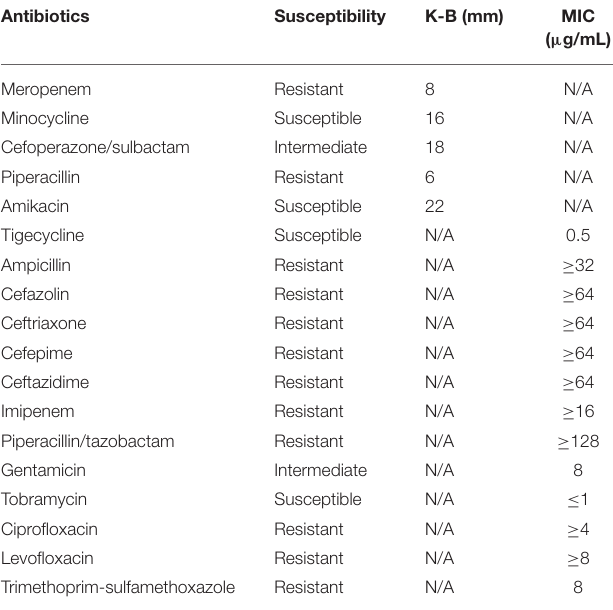
TABLE 2 | Antibiotics susceptibility tests for Acinetobacter baumannii in